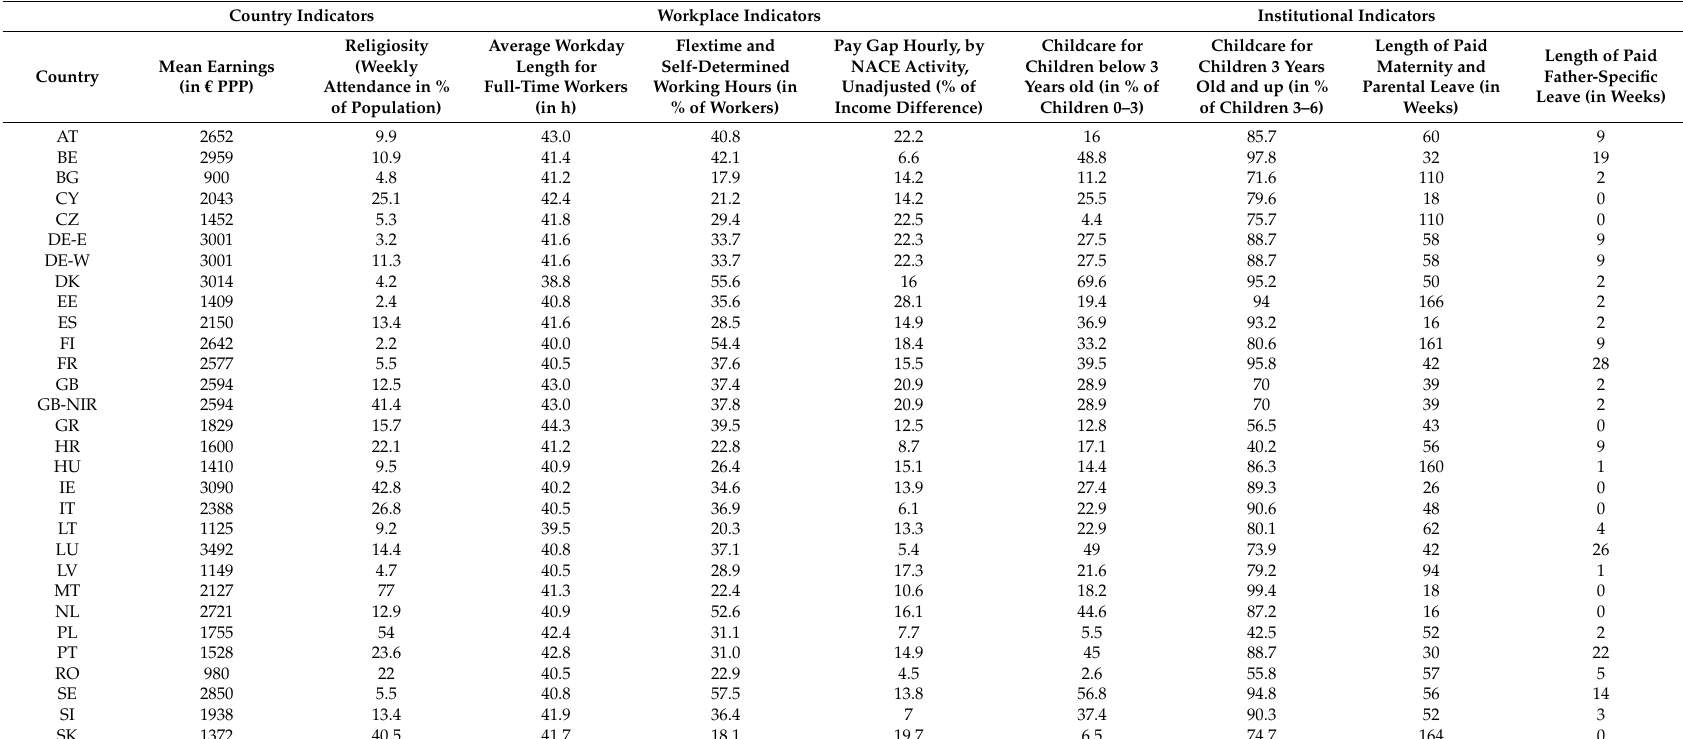
Table 2. Macro-level variables 12 and their distribution across